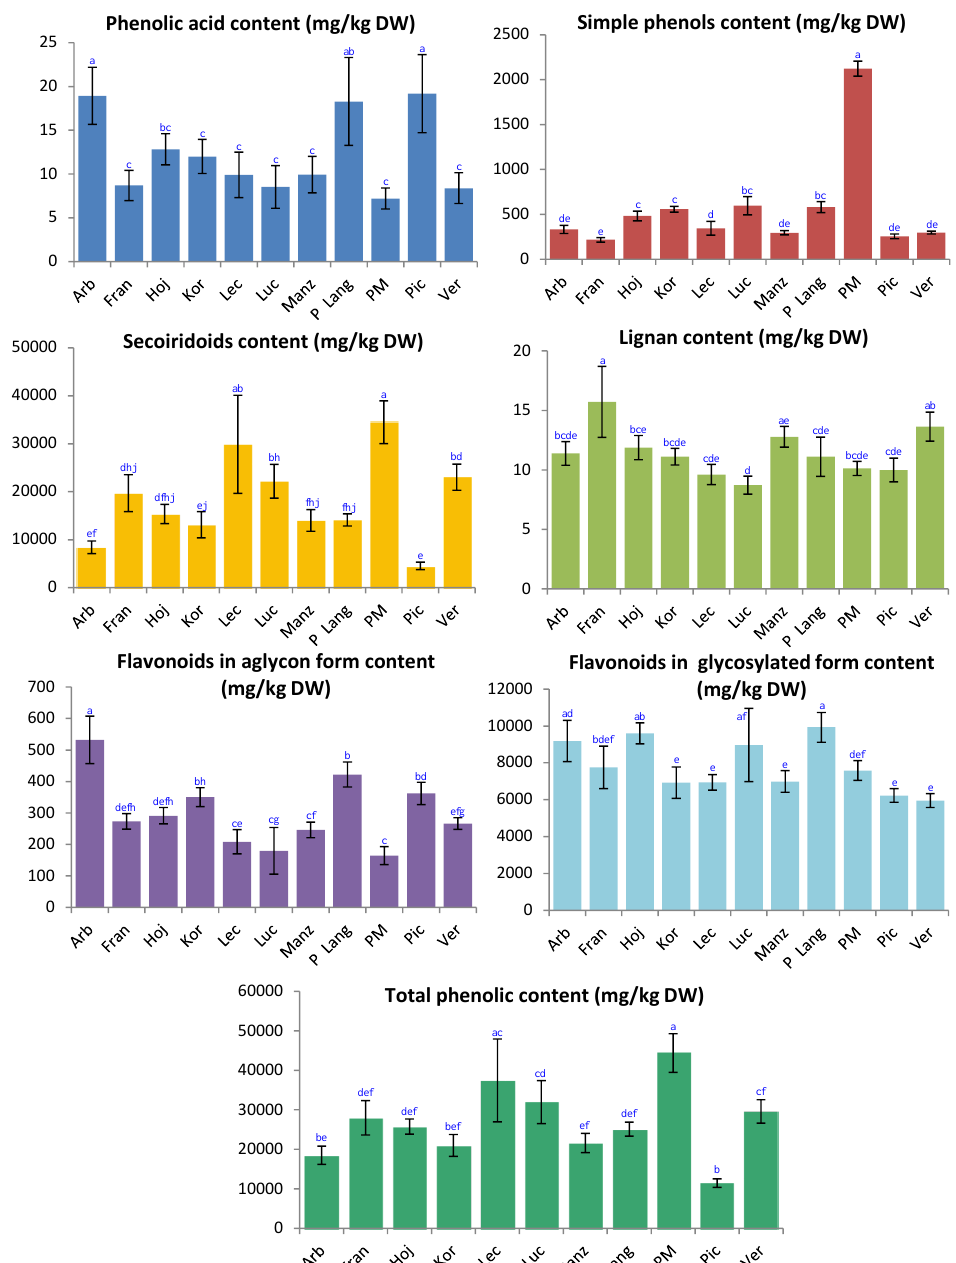
Figure 2. Total phenolic content and content in terms of the different chemical classes (content of secoiridoids, flavonoids in aglycon form, flavonoids in glycosylated form, simple phenols, one phenolic acid and one lignan) of the studied olive leaves samples, expressed in mg/kg DW. Different letters above the bars indicate significant differences at p < 0.05, Turkey’s test (comparison among the 11 cultivars investigated in this study). Abbreviations meaning (in alphabetical order): Arb: ‘Arbequina’; Fran: ‘Frantoio’; Hoj: ‘Hojiblanca’; Kor: ‘Koroneiki’; Lech: ‘Lechín’; Luc: ‘Lucque’; Manz: ‘Manzanilla’; P Lang: ‘Picholine de Languedoc’; PM: ‘Picholine Marocaine’; Pic: ‘Picual’; and Verd: ‘Verdal’.